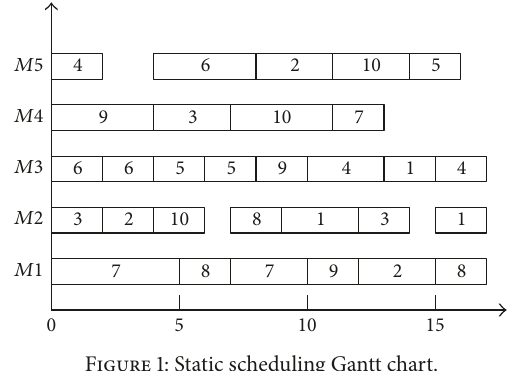
Figure 1: Static scheduling Gantt chart.